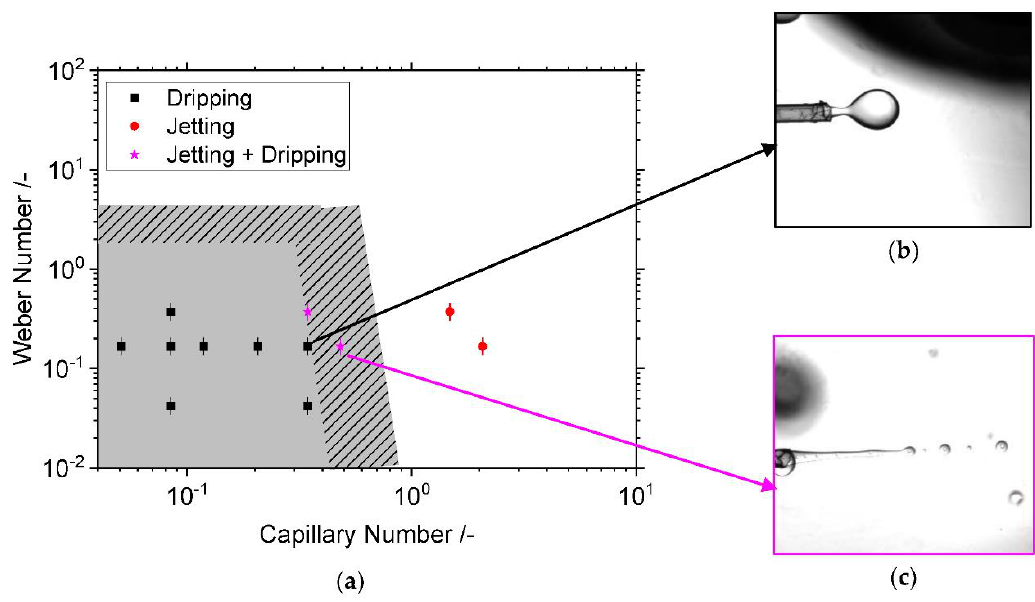
Figure 8. ( a ) Dripping and jetting droplet detachment mechanisms depending on the Capillary and the Weber Number. The grey crosshatched area illustrates the process conditions where both mechanisms can be present [30]. The grey colored area represents the process conditions where only dripping is expected according to [30]. ( b ) Raw picture of dripping regime at 𝐶𝑎 = 0.344 and 𝑊𝑒 = 0.166 . ( c ) Raw picture of jetting regime at 𝐶𝑎 = 0.482 and 𝑊𝑒 = 0.166